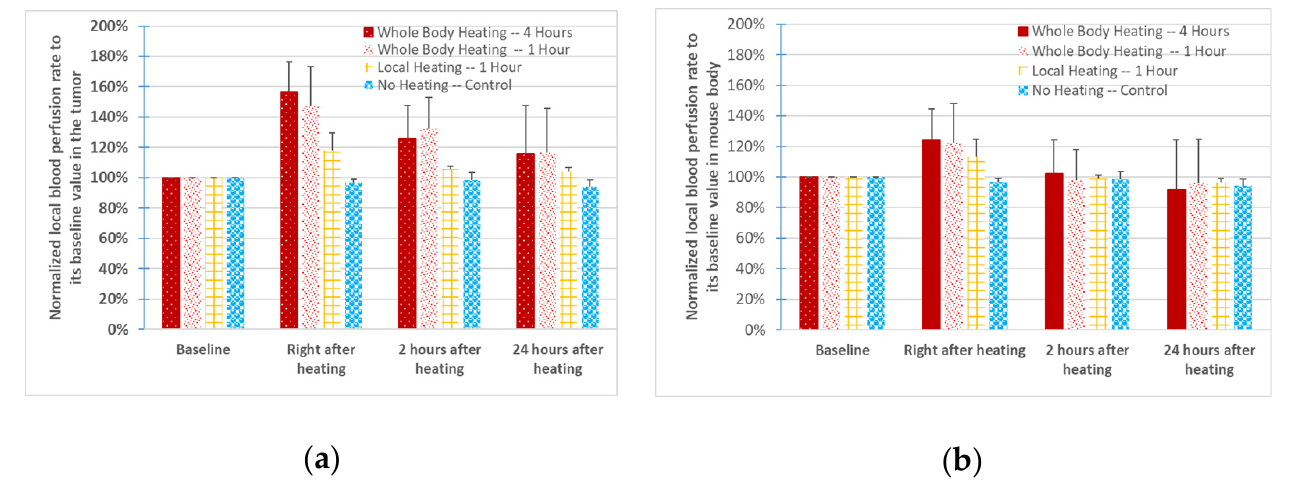
Figure 4. Local blood perfusion rates normalized to the baseline (before heating) values. Error bars represent the values of the standard deviation. ( a ) The left panel gives the values at the tumor site, and ( b ) the right panel shows the values for the mouse body.